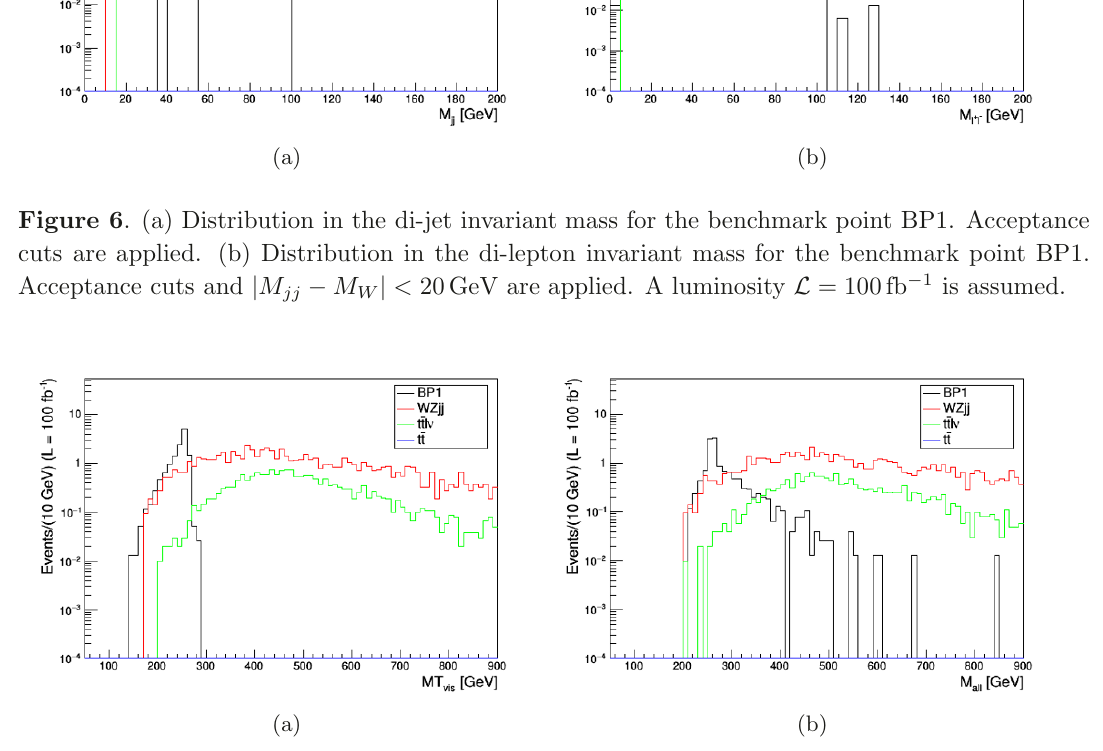
Figure 7 . (a) Distribution in the visible transverse mass of the final state. (b) Distribution in the total invariant mass of the final state obtained via a light neutrino reconstruction algorithm, as explained in the text. Acceptance cuts plus have been applied (see text). A luminosity